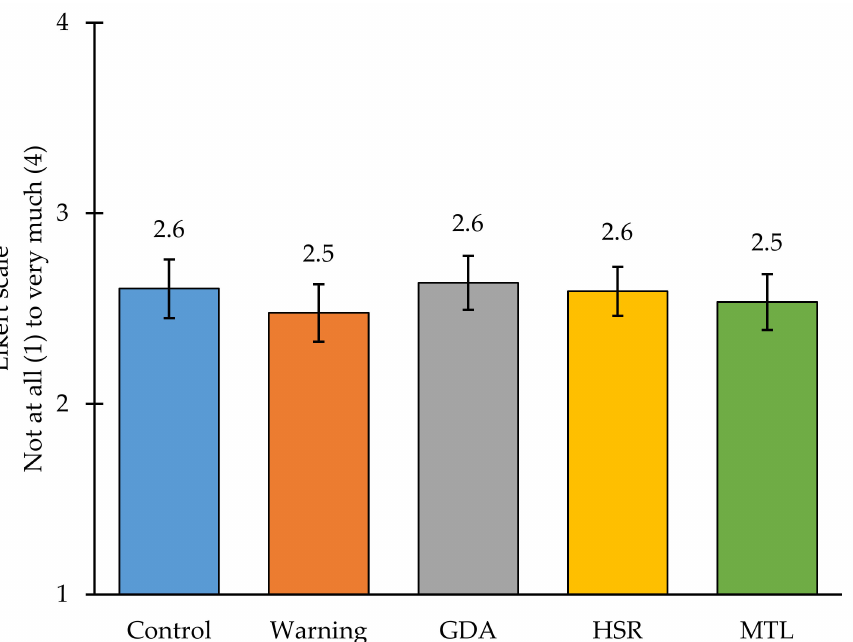
Figure 3. Mean purchase intentions by study arm. GDA—Guideline Daily Amount, HSR—Health Star Rating, MTL—Multiple Traffic Light